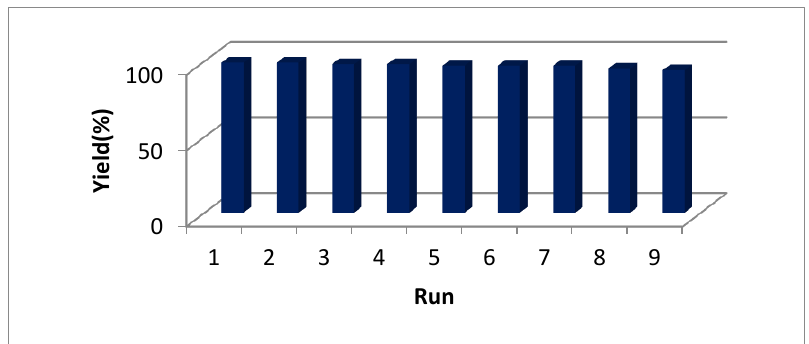
Figure 7. Reusability of the PMO-Py material in Knoevenagel condensation reaction between benzaldehyde and malononitrile under optimized conditions.